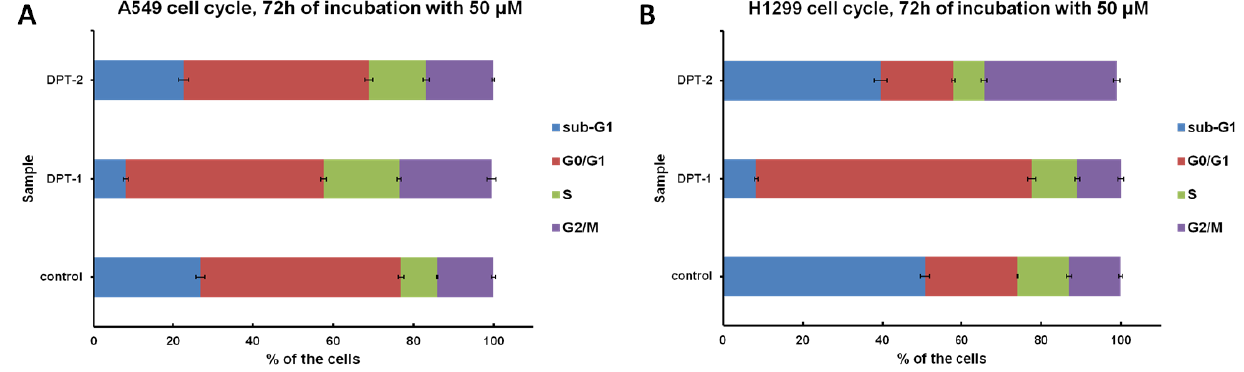
Figure 5. Cell cycle distribution in control and DPT-1 - and DPT-2 -treated A549 ( A ) and H1299 cells ( B ) treated for 72 h at a dose of 50 µM, followed by flow cytometry measurements.